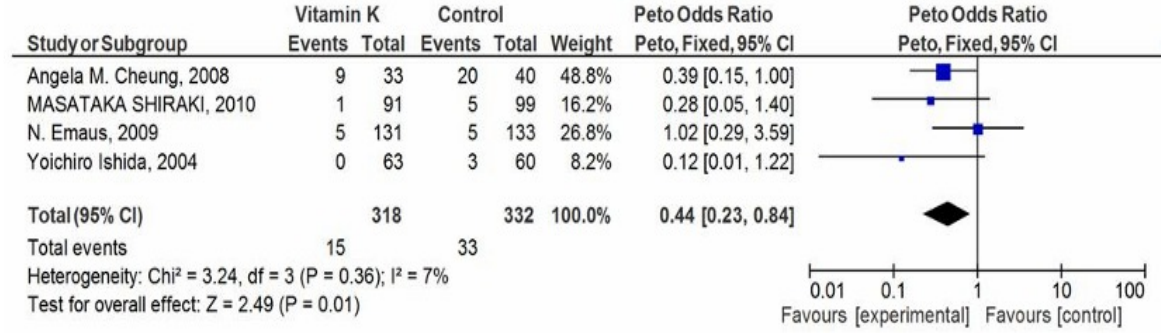
Figure 4. Forest Plot: Peto odds ratio for any clinical fracture outcome.